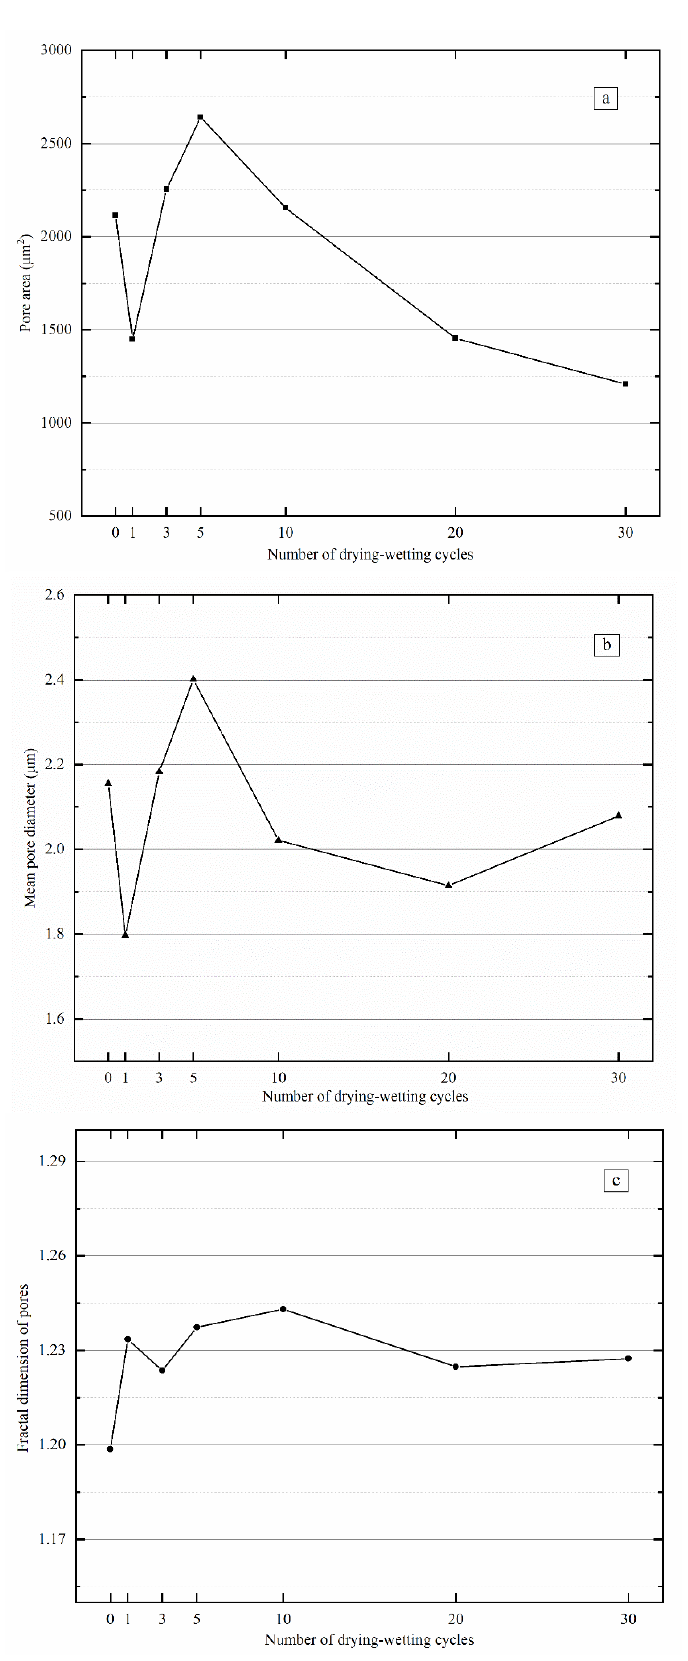
Figure 11. Relationship between the number of drying–wetting cycles and microstructural parame-